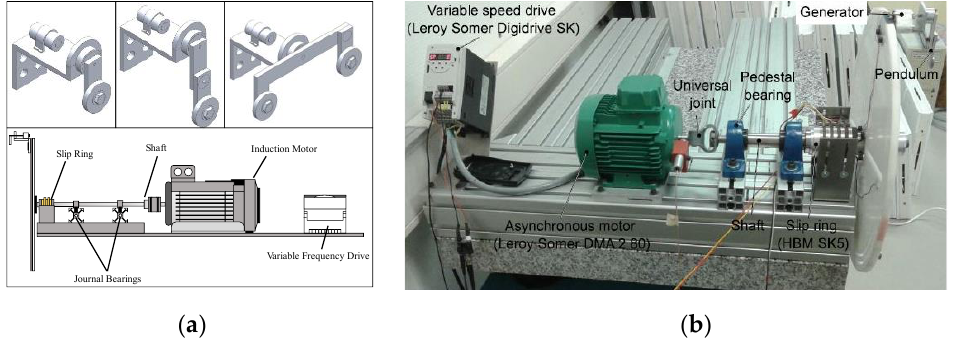
Figure 16. ( a ) Comparative experiment of pendulum energy harvesters [114]. ( b ) Experimental set up for imitating a car wheel [115]. Reprinted with permission from Ref. [115]. Copyright 2022,